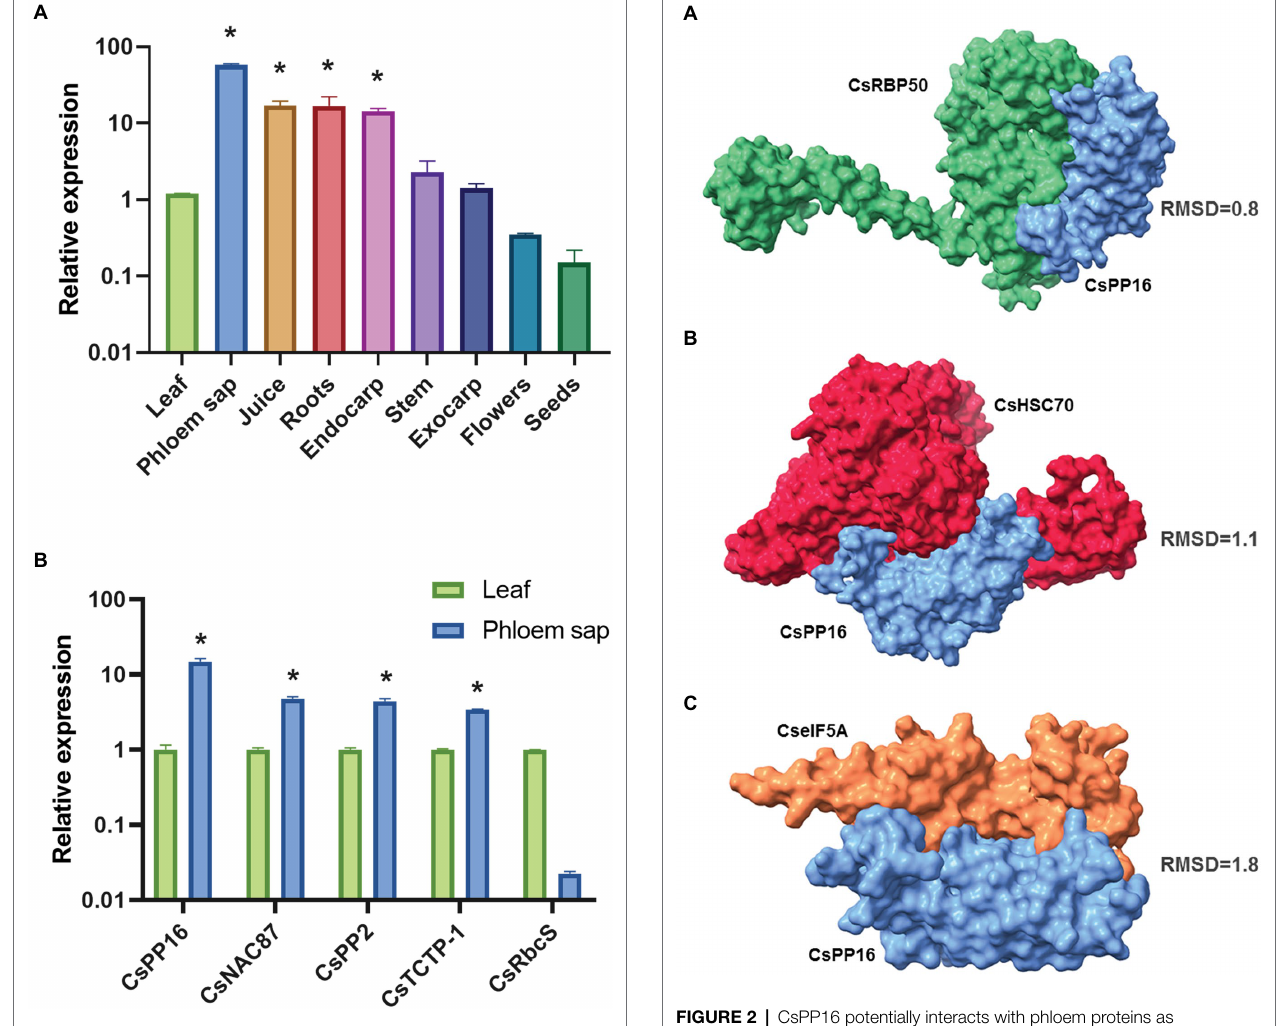
FIGURE 1 | Relative accumulation of CsPP16 mRNA in Citrus sinensis analyzed with Real-time quantitative PCR (RT-qPCR). Relative expression was normalized with the GAPDH transcript. (A) CsPP16 accumulation profile in different tissues and floral organs of adult C. sinensis plants. (B) Comparison of CsPP16 levels in young leaves and phloem of C. sinensis compared with other mRNAs potentially accumulating in the vasculature. Comparisons between the different genes or tissues with respect to leaf tissue were calculated using Student’s t -test (* p < 0.001).